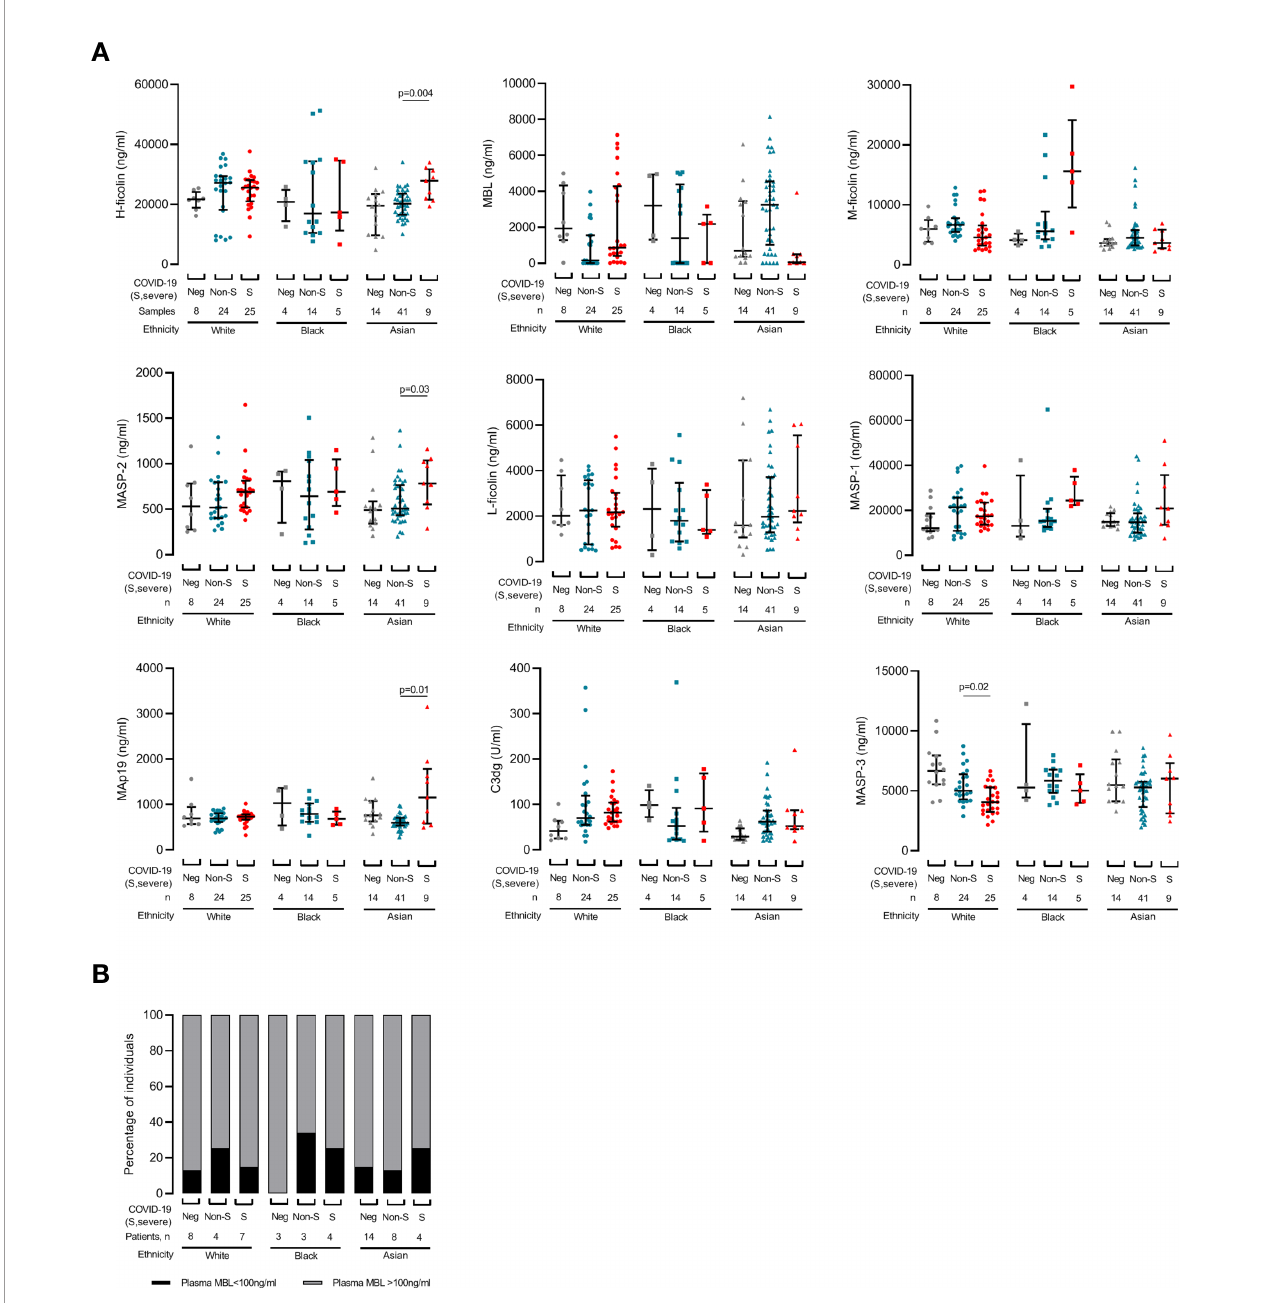
FIGURE 3 | Changes in lectin pathway protein levels during COVID-19 are in fl uenced by ethnicity. (A) Samples are grouped by patient self-reported White (circles), Black (squares) or Asian (triangles) ethnicity. 57 samples were collected from 19 White patients, 23 samples were collected from 10 Black patients, and 61 samples were collected from 26 Asian patients. COVID-19 status at sampling was negative ( ‘ Neg ’ , grey), non-severe ( ‘ Non-S ’ , blue) or severe ( ‘ S ’ , red) at sampling. We did not detect differences for CL-L1, CL-K1 and MAp44 (data not shown). Lines and whiskers show the cohort median and interquartile values. Differences between cohorts were calculated with a mixed model for repeated measures and P values adjusted for multiple comparisons as described in the methods. (B) Prevalence of MBL de fi ciency, de fi ned as plasma MBL level less than 100ng/ml, in each ethnicity and severity